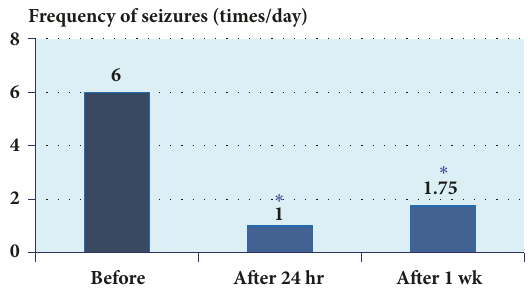
Figure 1: Comparison between seizure baseline 1 month before IV LCM and after IV LCM at 24 hours and 1